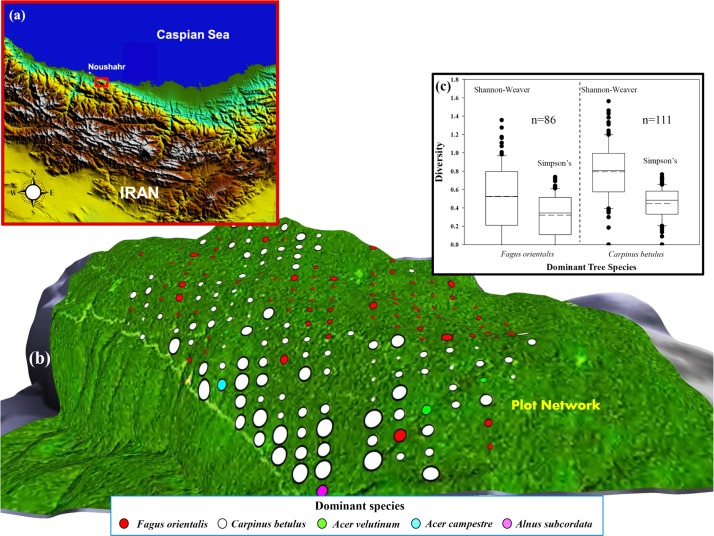
Study site in northern Iran.(a) inset map and (b) network of forest-inventory plots central to the study. Location of the port city of Noushahr in the inset map is indicated next to the plot network. Coloured circles in (b), representing individual plots, vary in size according to observed tree species richness; large circles represent plots with high tree species richness (e.g., SR = 7 species per 0.1-ha plot) and small circles, low species richness (e.g., SR = 1 species per 0.1-ha plot). Plot tree-species dominance (accounting for ≥ 33% of all trees in a plot) is labelled by colour. Boxplots in (c) give species diversity as a function of the Shannon-Weaver and Simpson’s index for Fagus orientalis- and Carpinus betulus-dominated plots, covering 97.5% of all plots considered (197 of 202 plots). The remaining plots are dominated by Acer velutinum (3 plots), Acer campestre (1 plot), and Alnus subcordata (1 plot). The median and mean of individual distributions are indicated by the solid and dashed lines within the boxes. The 25th and 75th percentile of the data are given as the lower and upper boundaries of the box; the 10th and 90th percentile are given at the lower and upper limits of the whiskers. Values smaller or larger than the 10th and 90th percentile are indicated as black circles.